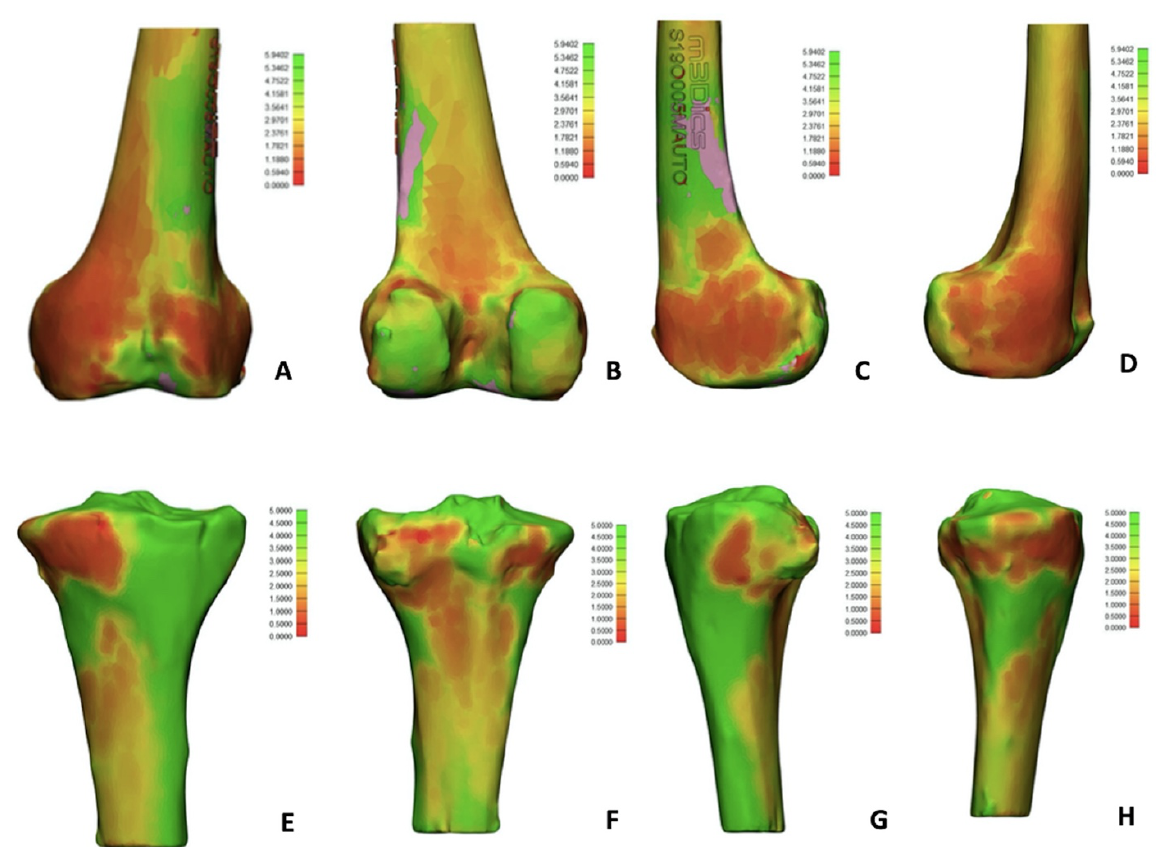
Figure 3. Bone thickness evaluation: red zones correspond to lower thickness (0.1 mm) while green zones correspond to higher thickness (6 mm). ( A ) Anterior femoral side; ( B ) posterior femoral side; ( C ) medial femoral side; ( D ) lateral femoral side; ( E ) anterior tibial side; ( F ) posterior tibial side; ( G ) medial tibial side; ( H ) lateral femoral side.